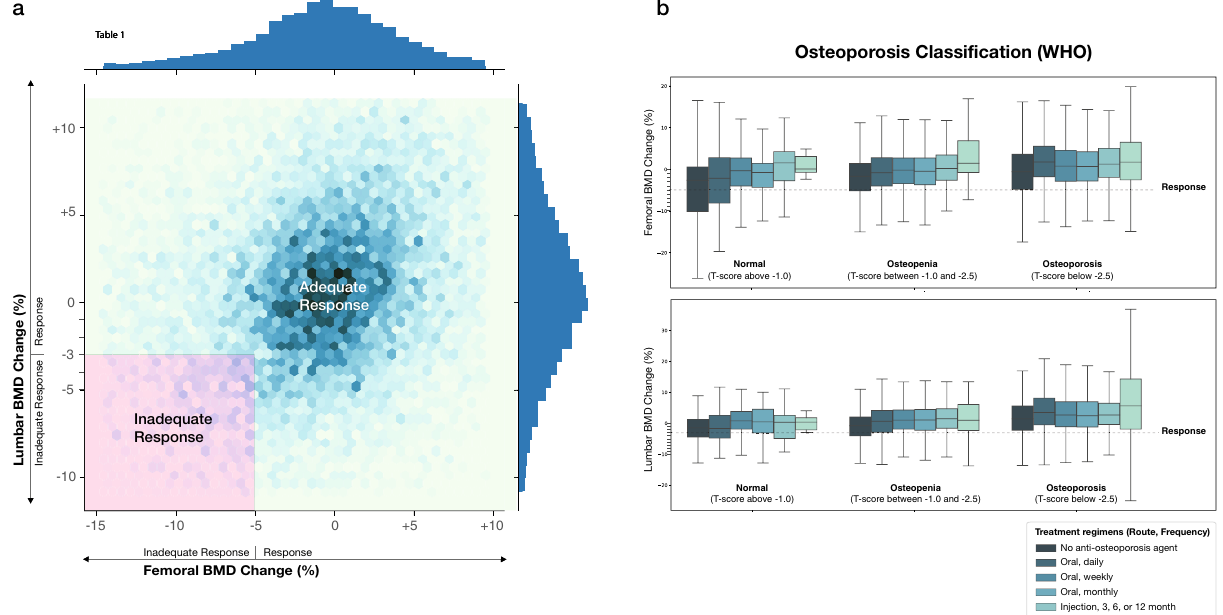
Inadequate Response